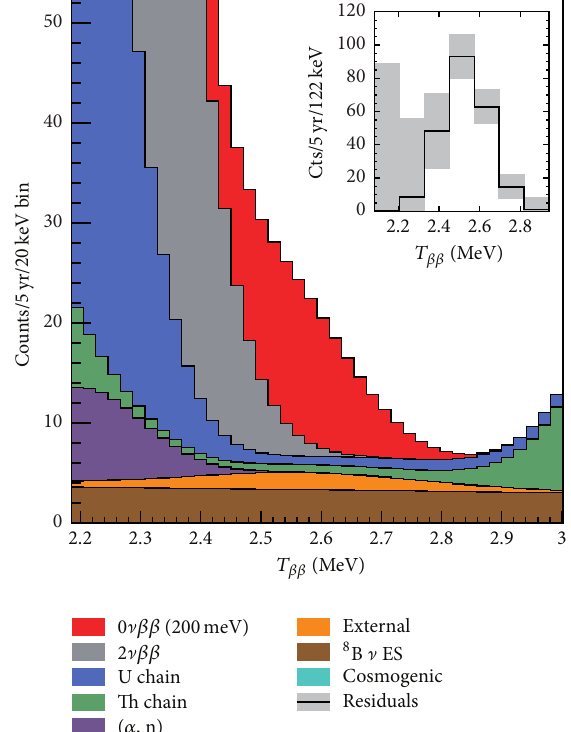
Figure6:Summarystackedplotofallbackgroundsandahypotheti- cal 0 ] 𝛽𝛽 signal corresponding to a mass 𝑚 𝛽𝛽 = 200 meV for 5-year data taking. Events are shown in the FV of 3.5 m, for 0.3% natural tellurium loading and 200 Nhits/MeV light yield. 𝑇 𝛽𝛽 is the effective kinetic